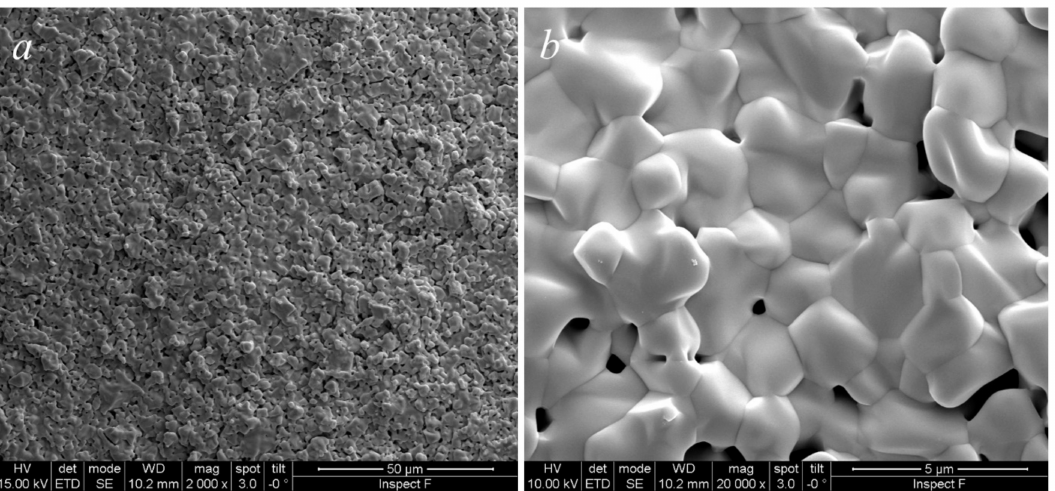
Figure 5. SEM micrographs of CeZrYLaGd-N sintered at 1500 ◦ C for 4 h at lower magnification ( a ) and higher magnification ( b ).